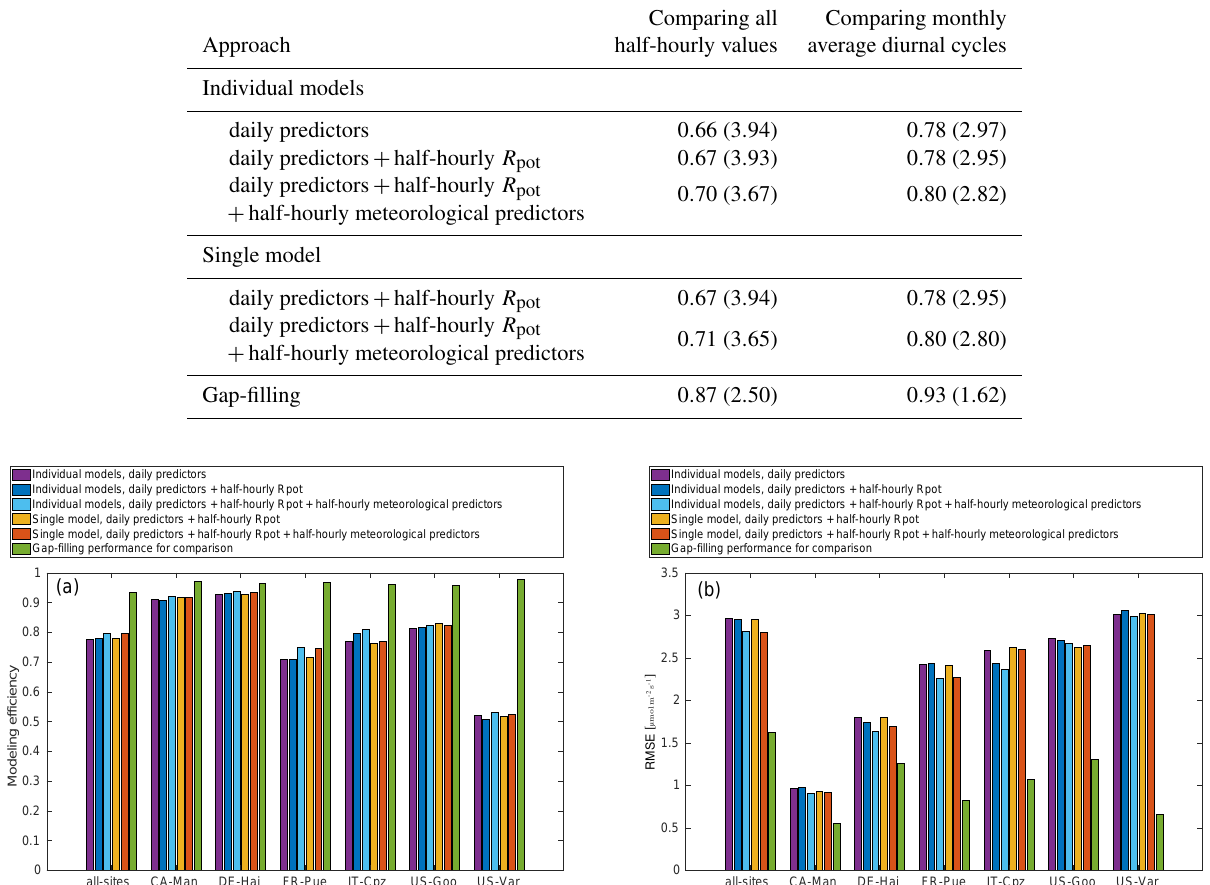
all-sites CA-Man DE-Hai FR-Pue IT-Cpz US-Goo